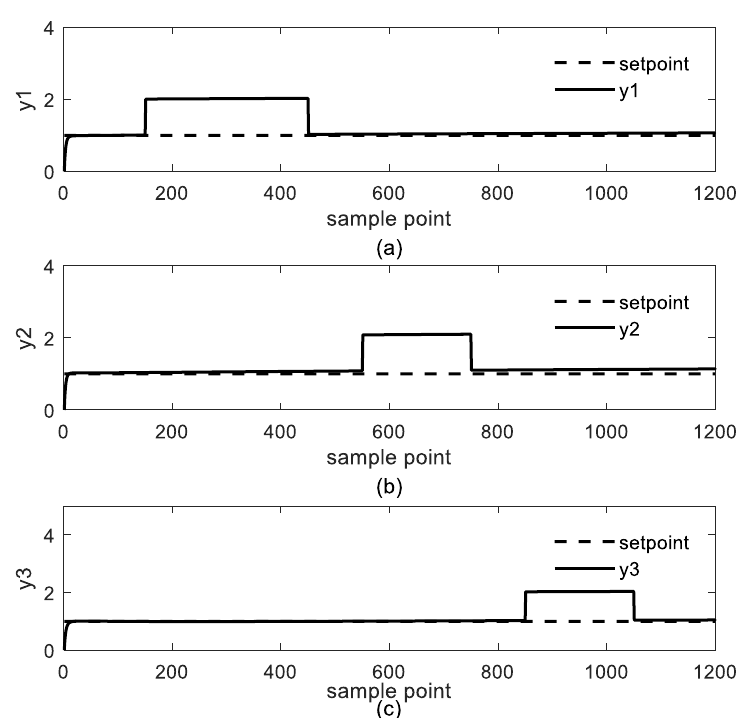
Figure 13. The simulation result of MSDP without noise: ( a ) y 1 —production; ( b ) y 2 —slurry polymer; ( c ) y 3 —catalyst efficiency.